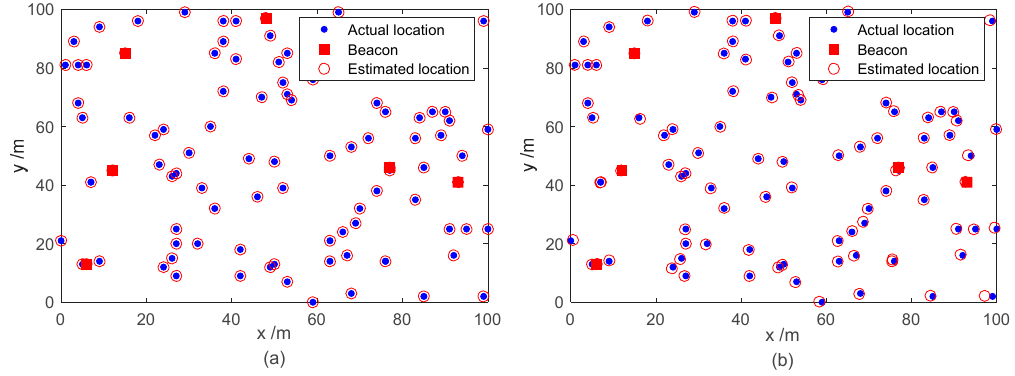
Figure 9. Localization results of the LBDMC with different noise environments. The sampling rate is fixed at 30%: ( a ) Localization results under Case 1; ( b ) Localization results under Case 4.